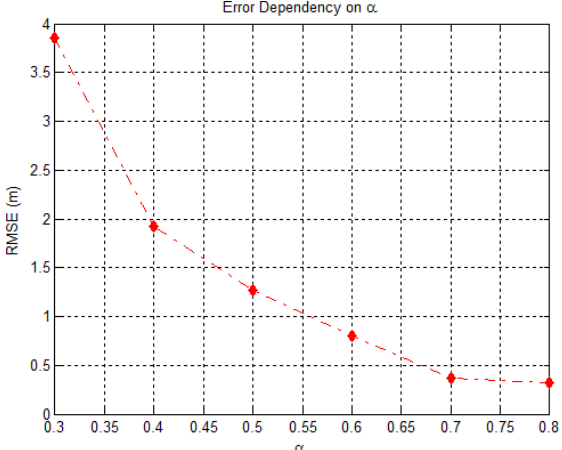
Figure 3. Root Mean Square Error (m) as a function of α , when σ 2 ν = − 25 dB and β = 0.1.